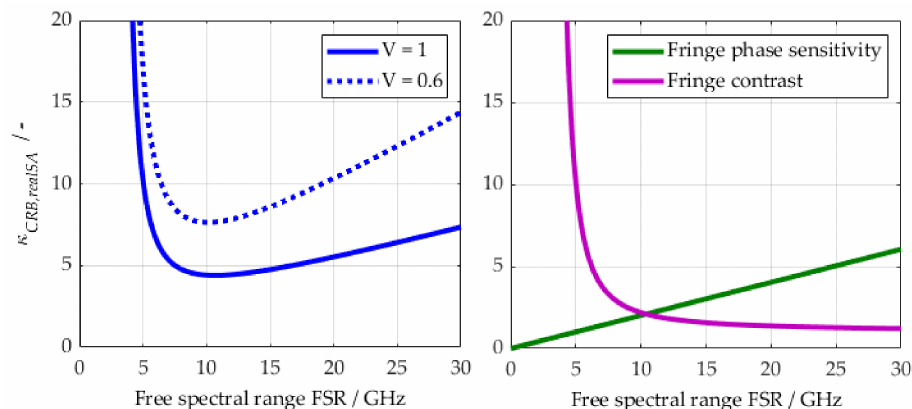
Figure 4. ( Left ): The Cram é r-Rao lower-bound of our implementation of the FW-FIMI for single- channel use as a function of the free spectral range (simplified Figure 1 from [43]). ( Right ): Competing components of the left figure, the fringe phase sensitivity and the global fringe contrast.